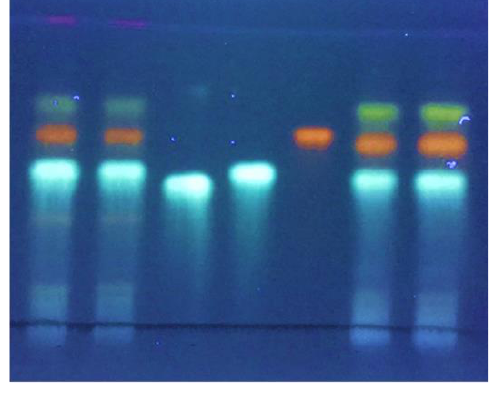
Figure 2. HPTLC profile of both M. oleifera leaf water extracts obtained by microwave irradiation (each seeded twice) and three reference standards sprayed with NP/PEG reagent; MLEB: M. oleifera Barletta; MLES: M. oleifera Salento; CA: chlorogenic acid; NCA: neochlorogenic acid; QGP: quercetin 3- O - β - D -glucopyranoside; solvent: ethyl acetate:formic acid:acetic acid:water (100:11:11:26); λ : 366 nm.